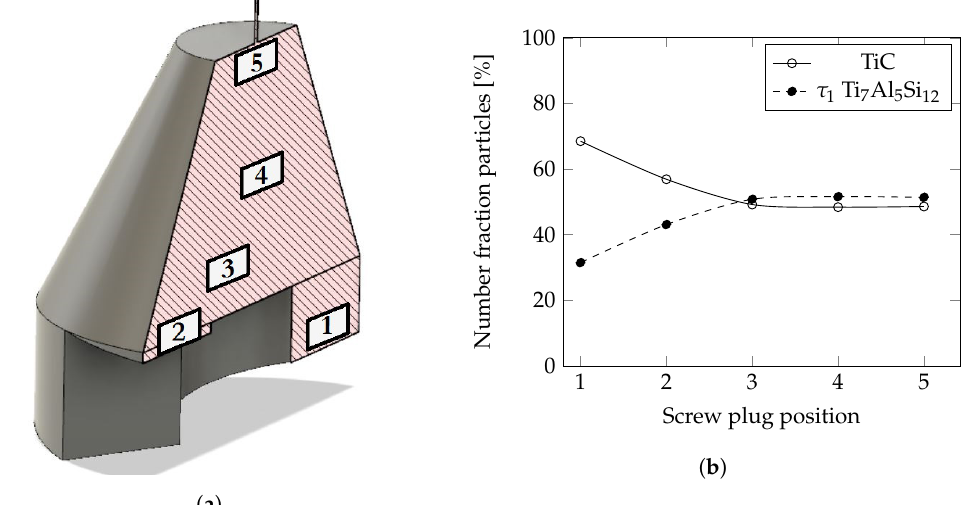
Figure 8. Transformation of TiC into τ 1 (Ti 7 Al 5 Si 12 ) during metal screw extrusion through